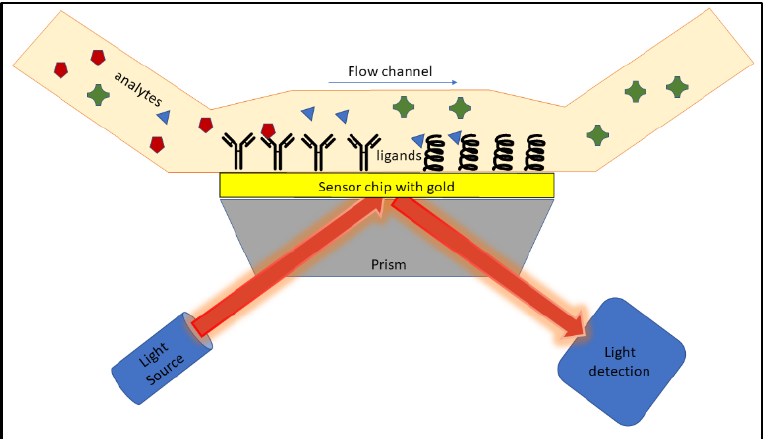
Figure 9. Schematic representation of SPRi. Analytes flowing in the channel bind to ligands grafted on a gold surface. This interaction is detected by a change in the intensity of the light reflected on the other side of the gold surface.